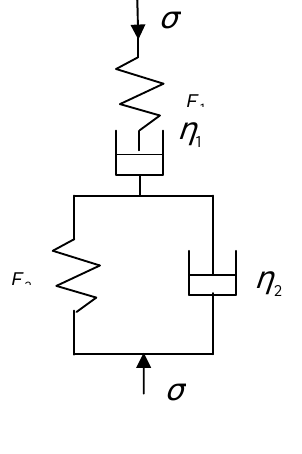
Figure 5. Maxwell-Kelvin